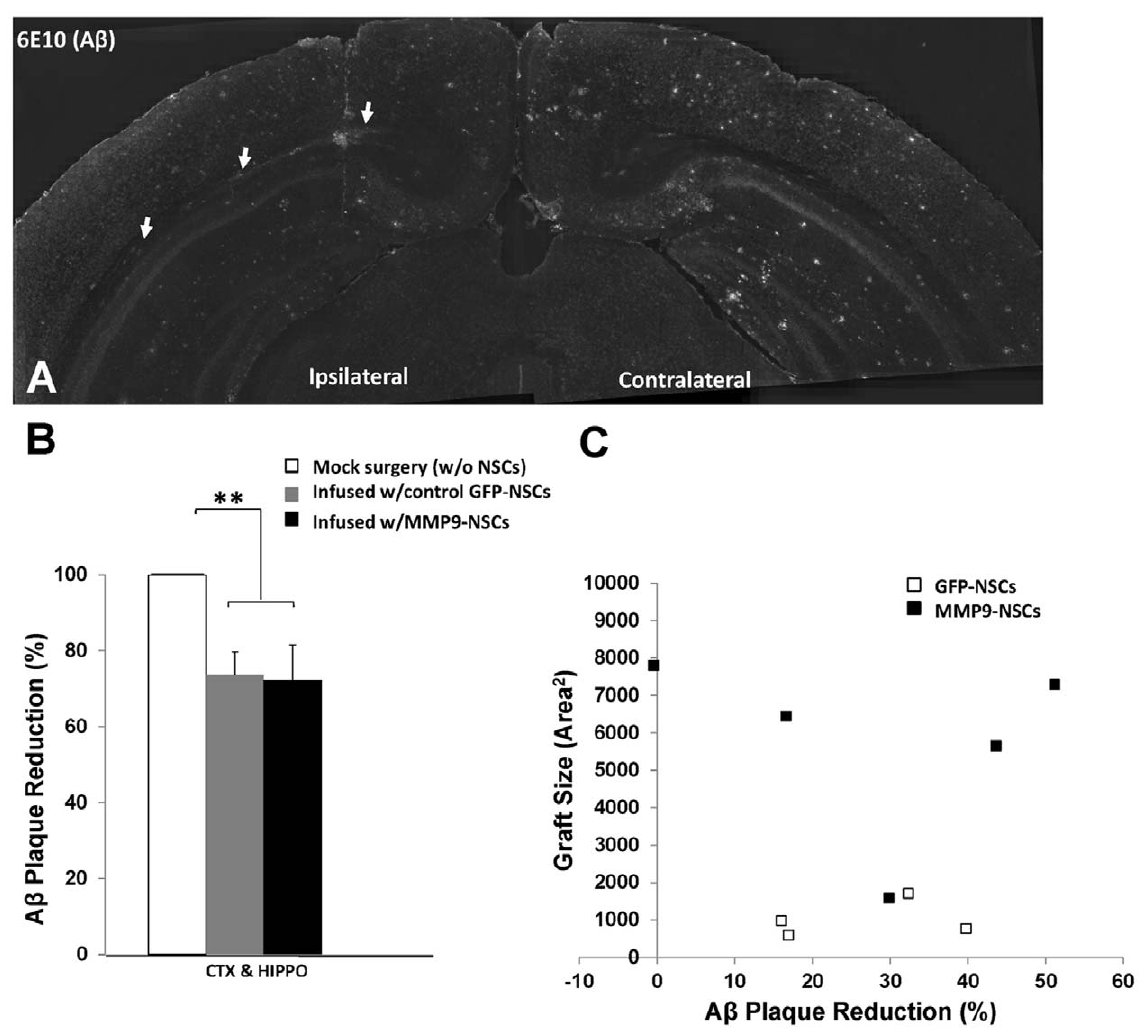
Figure 6. NSC transplantation but not MMP9 overexpression was associated with reductions in A b plaque burden in APPswe/ PS1dE9 mice. In mice with month-long engraftments, A b plaques were reduced in the area proximal to grafts in the hemisphere receiving NSCs (A, ipsilateral hemisphere, arrows mark the location of the graft). Across all animals, A b plaques were reduced by 27% (B, n=9 animals). Mice receiving MMP9-NSCs (n=5) had substantially enlarged engraftments relative to GFP-NSCs (n=4). However, the magnitude of A b plaque reduction was similar in both cohorts (B–C, closed squares=MMP9-NSCs, open squares=GFP-NSCs) and there was no obvious relationship between the size of the graft and the magnitude of plaque reduction. A b plaque burden determined from five to seven sections per animal. Engraftment size in each animal was determined in sections containing a needle track (**, p , 0.01).